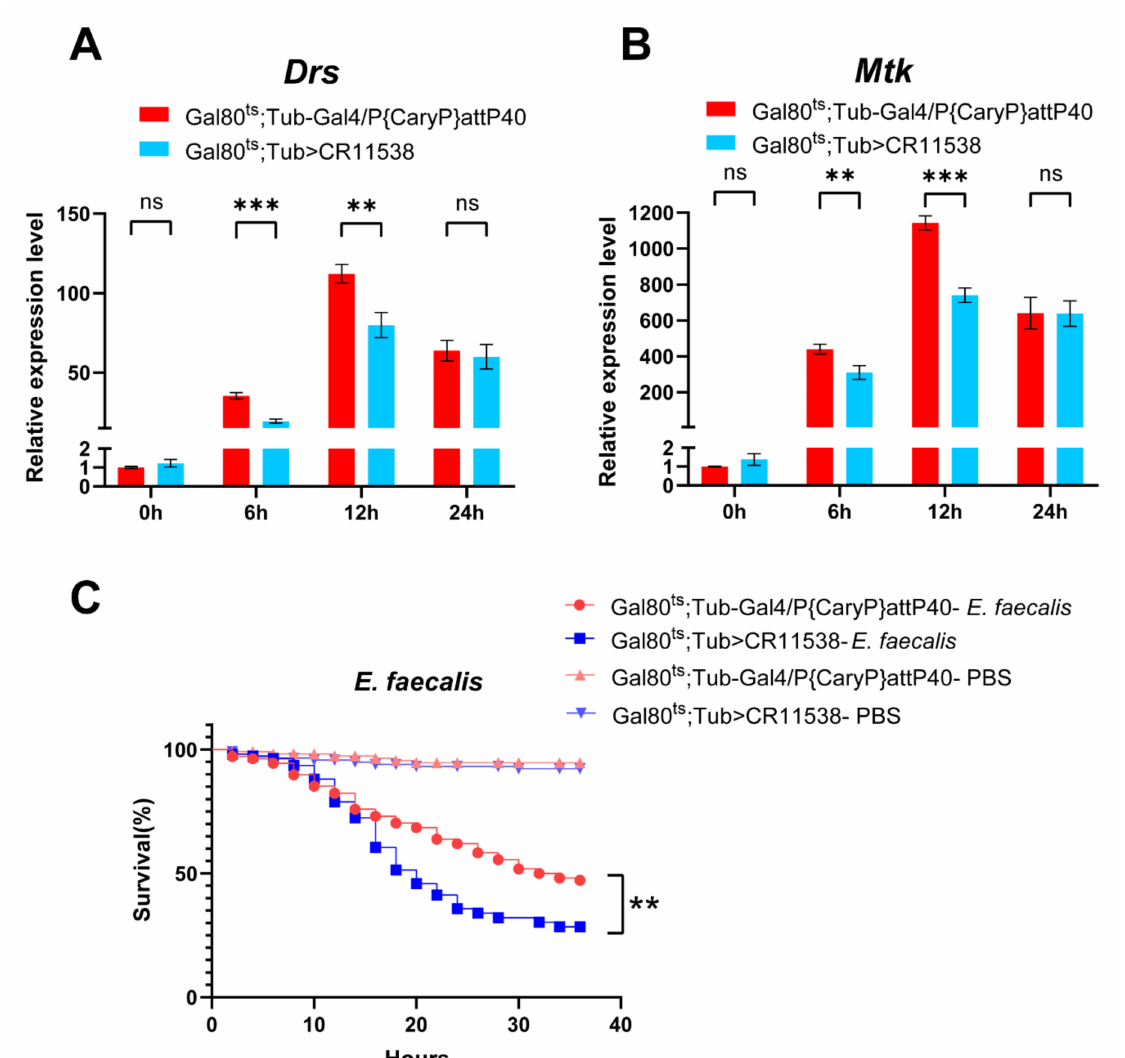
Figure 3. lncRNA-CR11538 inhibits Toll signaling pathway in vivo. Drs ( A ) and Mtk ( B ) expression levels in the CR11538- overexpressing flies at different time points (0 h, 6 h, 12 h, 24 h) after M. luteus infection. ( C ) Changes in the survival rate of the CR11538-overexpressing flies and the control flies treated with PBS or E. faecalis . Measurements made after 36 h. Gal80 ts ; Tub-Gal4/P{CaryP}attP40 -PBS ( n = 115), Gal80 ts ; Tub > CR11538 -PBS ( n = 118), Gal80 ts ; Tub-Gal4/P{CaryP}attP40 - E. faecalis ( n = 108), Gal80 ts ; Tub > CR11538 - E. faecalis ( n = 109). For all tests, p value < 0.05 was considered as statistically significant. ** p < 0.01, *** p < 0.001 and ns, no significance vs. the control